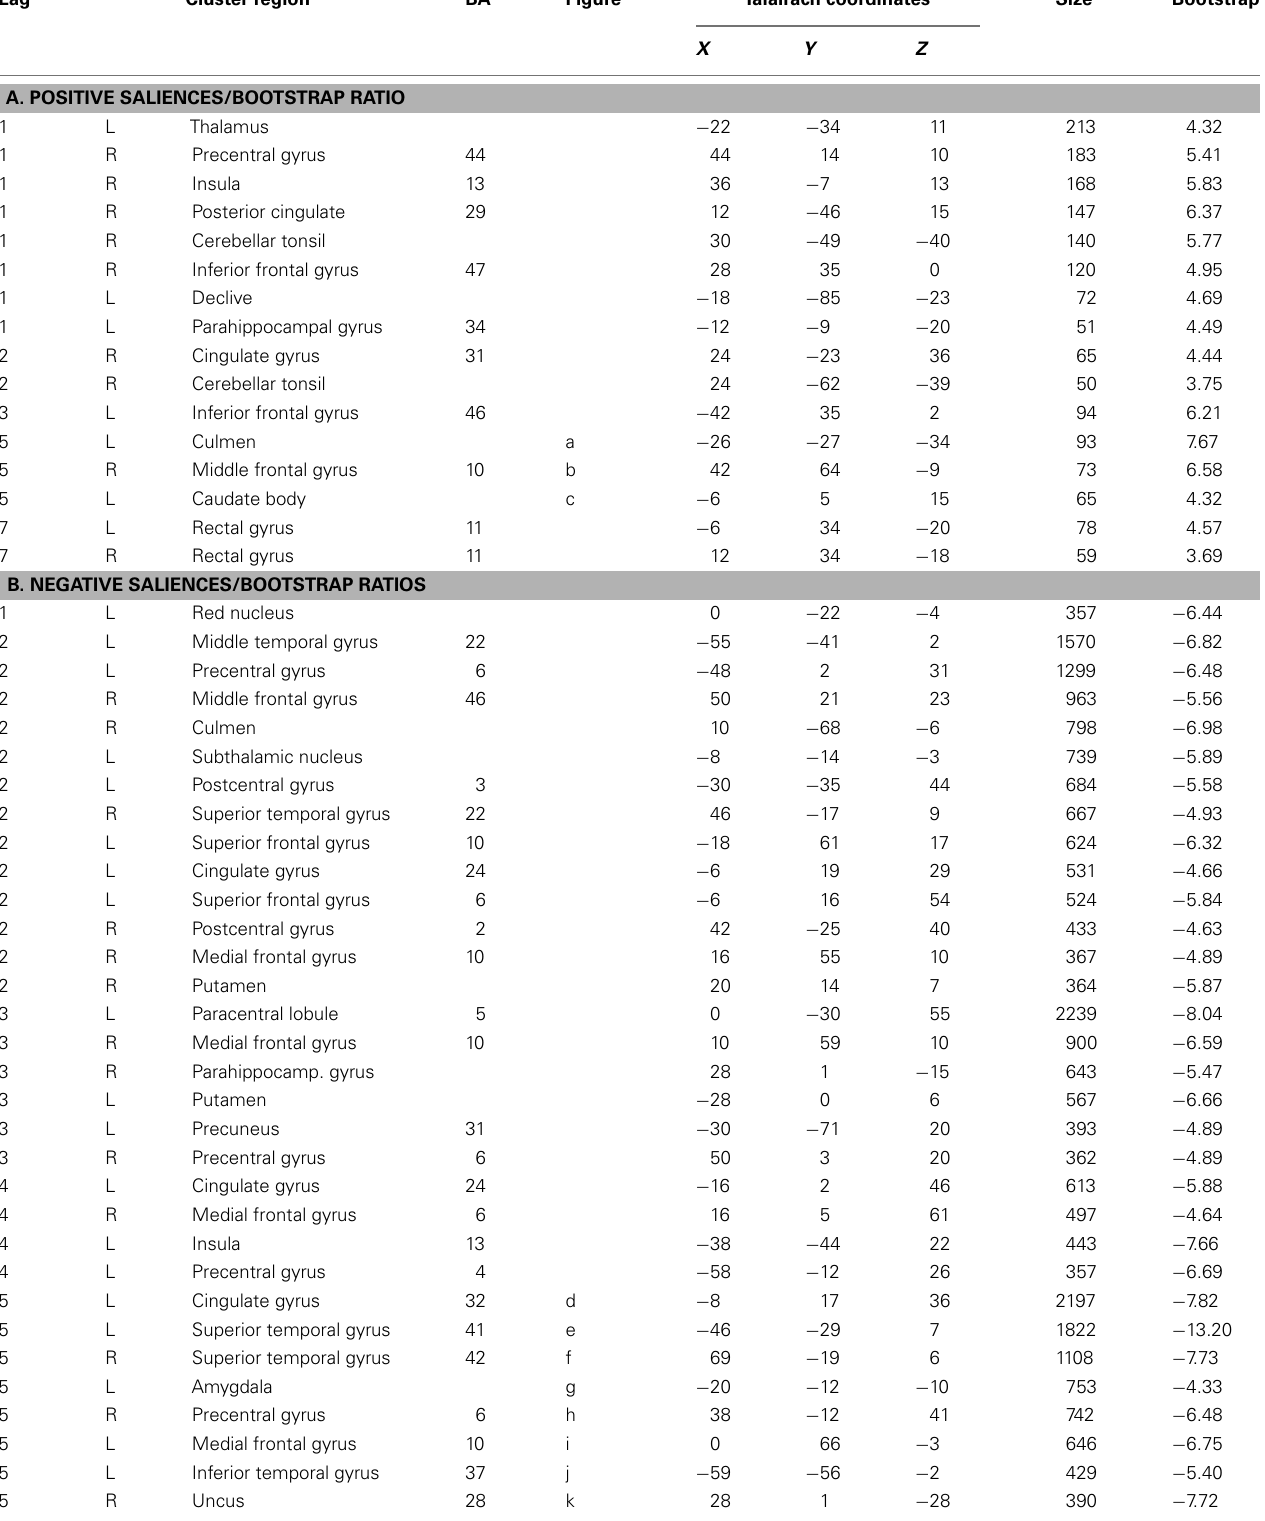
Table 2 | Reliable clusters identified for the significant LV in the task PLS analysis (bootstrap ratios ≥± 2.5). Lag Cluster region BA Figure Talairach coordinates Size